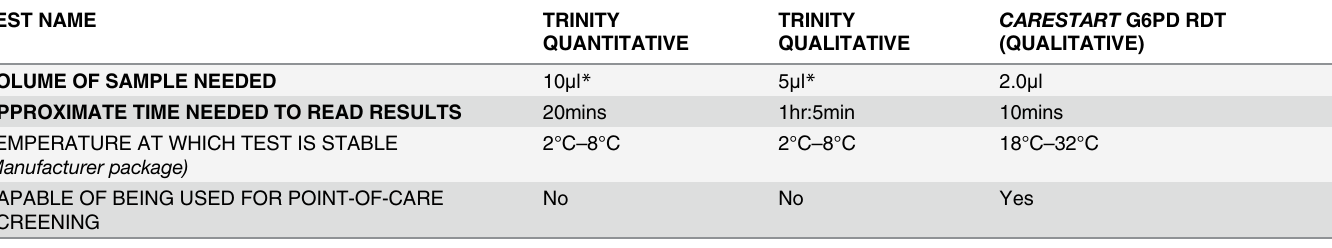
Table 1. An outline comparing some common factors of importance between the methods used for G6PD screening in the